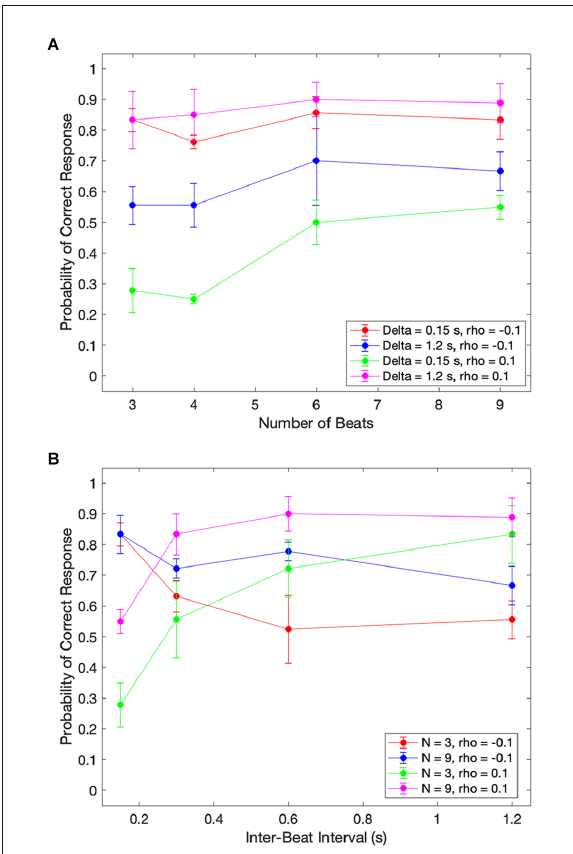
FIGURE4 Dependence of median performance as a function of number of beats and the inter-beat interval. (A) Dependence on the number of beats parametric on the inter-beat interval and the relative deviation of the last interval. (B) Dependence on the inter-beat interval parametric on the number of beats and the deviation of the last interval. The performance as a function of the number of beats is constant except when the inter-beat interval is short and the deviation of the last interval is positive. Thus, performance improves with the number of beats. The performance as a functionoftheinter-beatintervalimproveswhenthedeviationof the last interval is positive. However, the opposite happens when this deviation is